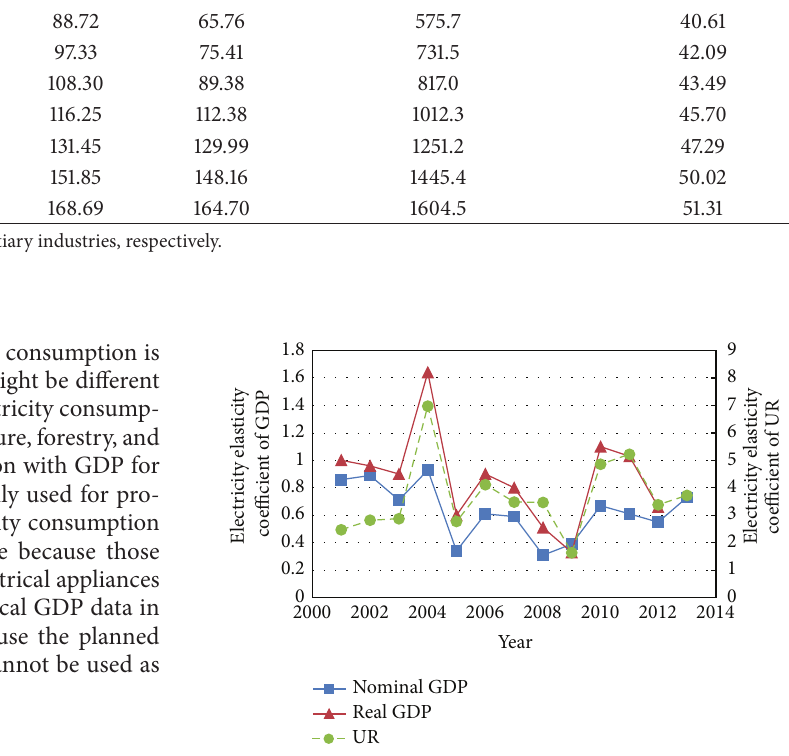
Figure 3: Electricity/GDP elasticity coefficient of Shaanxi province from 2001 to